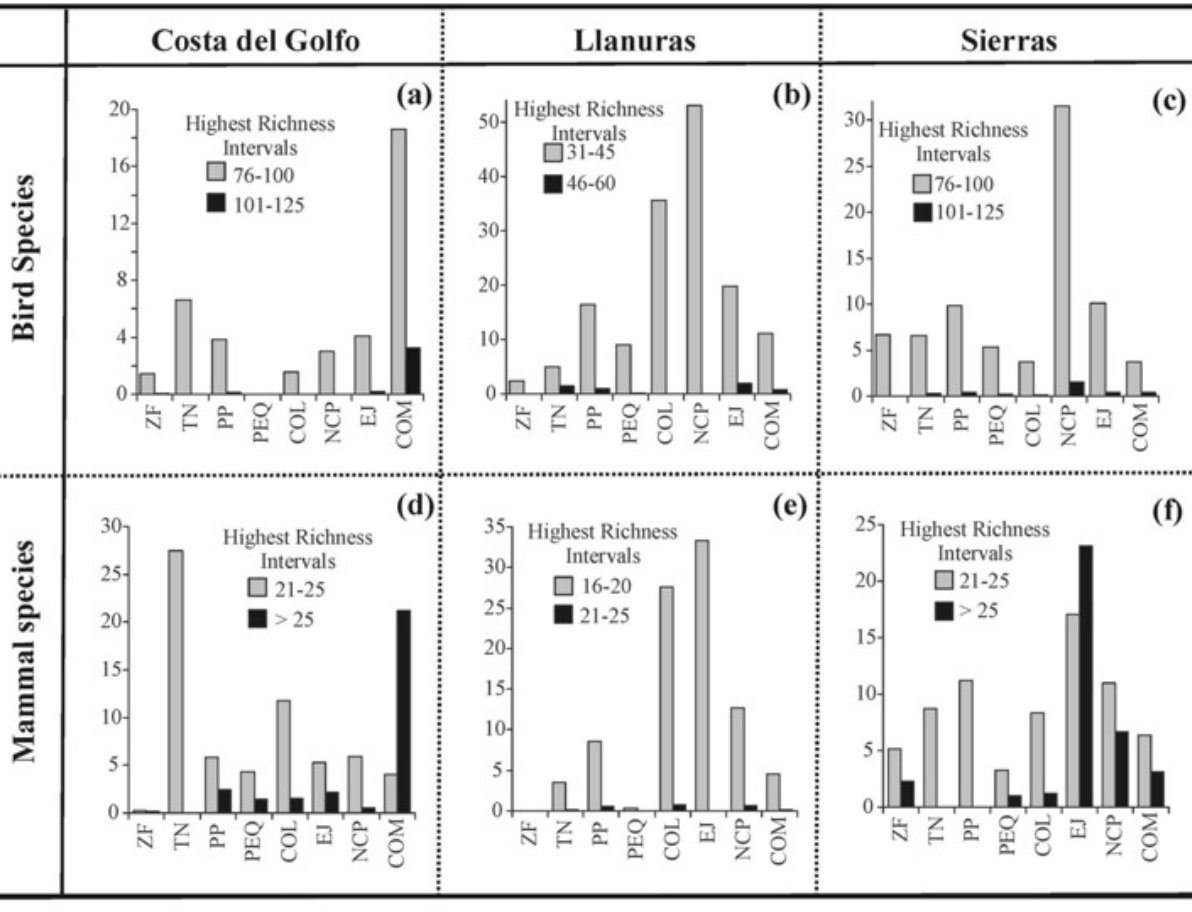
Fig. 6. Highest current bird and mammal species richness by land ownership type, in three subregions: Costa del Golfo, Llanuras, and Sierras . Land ownership types (x-axis) include ZF= federal lands, TN= Nation lands, PP= private property, PEQ= small private property, COL= colonia, a settlement for agriculture/cattle-raising, EJ= Ejido, COM= communal, and NCP= new population settlement (new Ejido ). Y-axis represents the percentage of each land ownership type containing species richness, as shown in